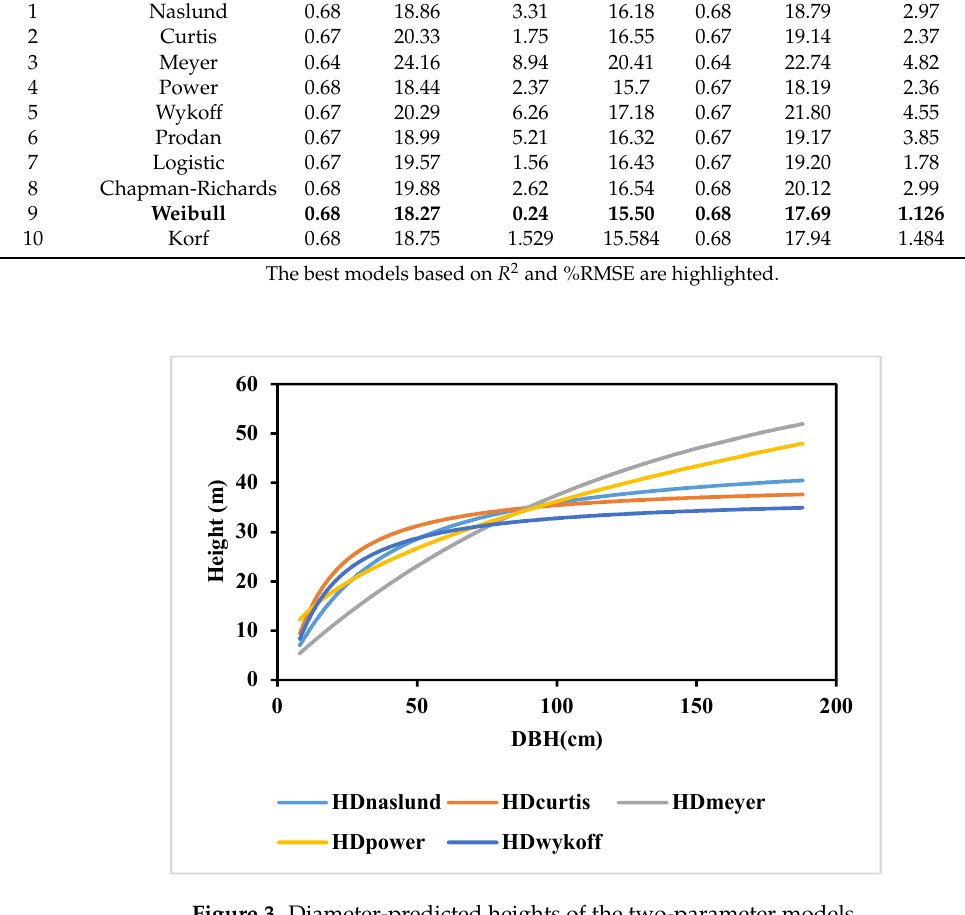
Figure 3. Diameter-predicted heights of the two-parameter models.